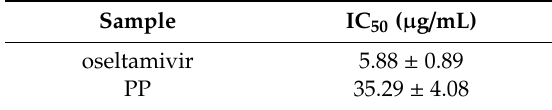
Table 5. Anti-neuraminidase activity of PP and